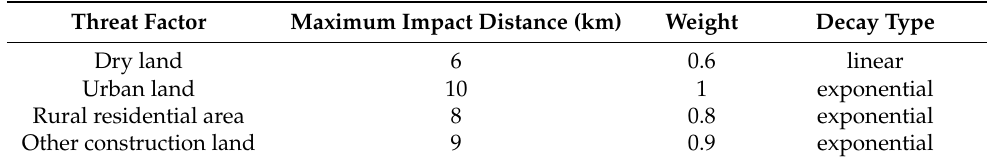
Table 1. Habitat threat factors and threat degree.